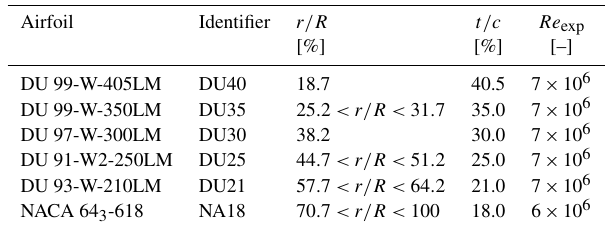
Table 1. Airfoils composing the wind turbine blade.